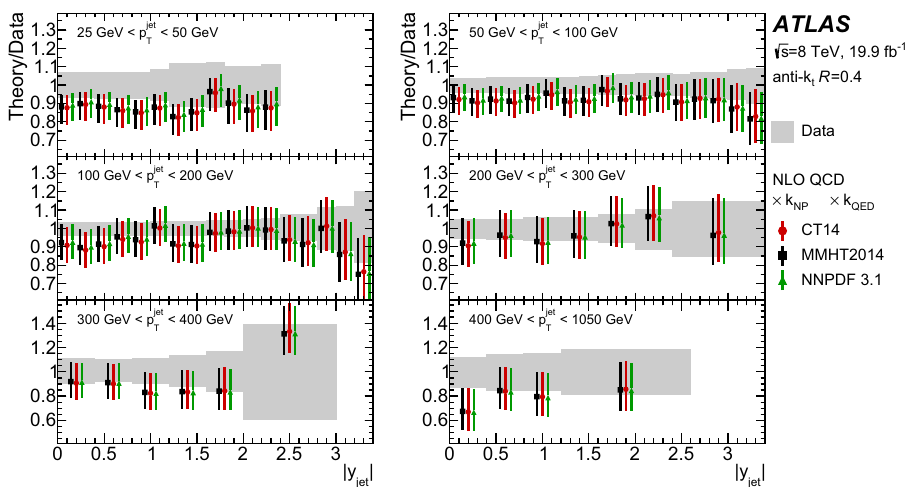
Fig. 13 Ratio of the measured Z + jets production cross-section and the NLO QCD predictions, obtained using MCFM, corrected for the non-perturbative and QED radiation effects as a function of | y jet | and p jet bins. Theoretical predictions are calculated using various PDF sets. T The coloured error bars represent the sum in quadrature of the effects